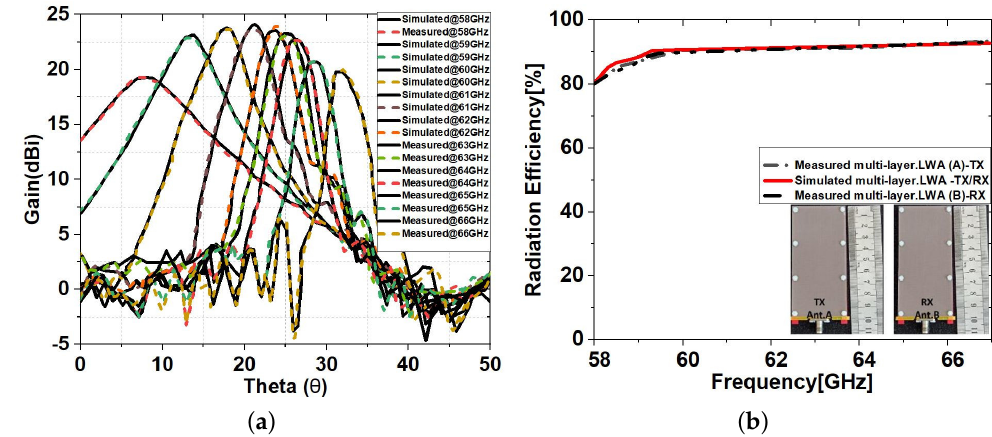
Figure 12. The measured and simulated ( a ) E -plane radiation patterns of the multi-layer LWA and ( b ) radiation